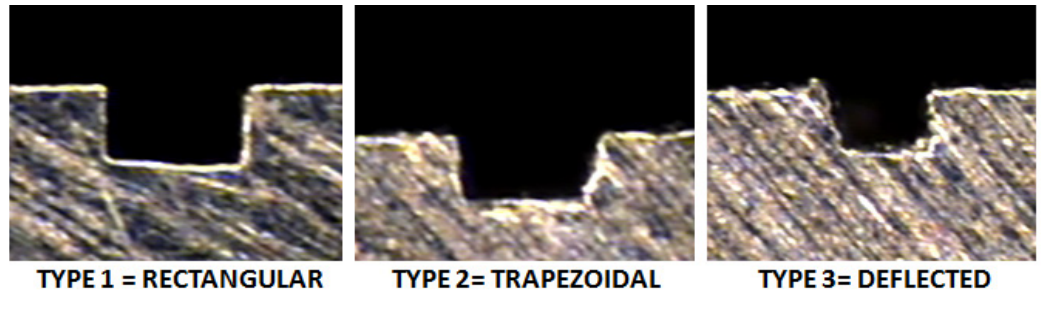
Figure 15. Common categorized profiles in Al